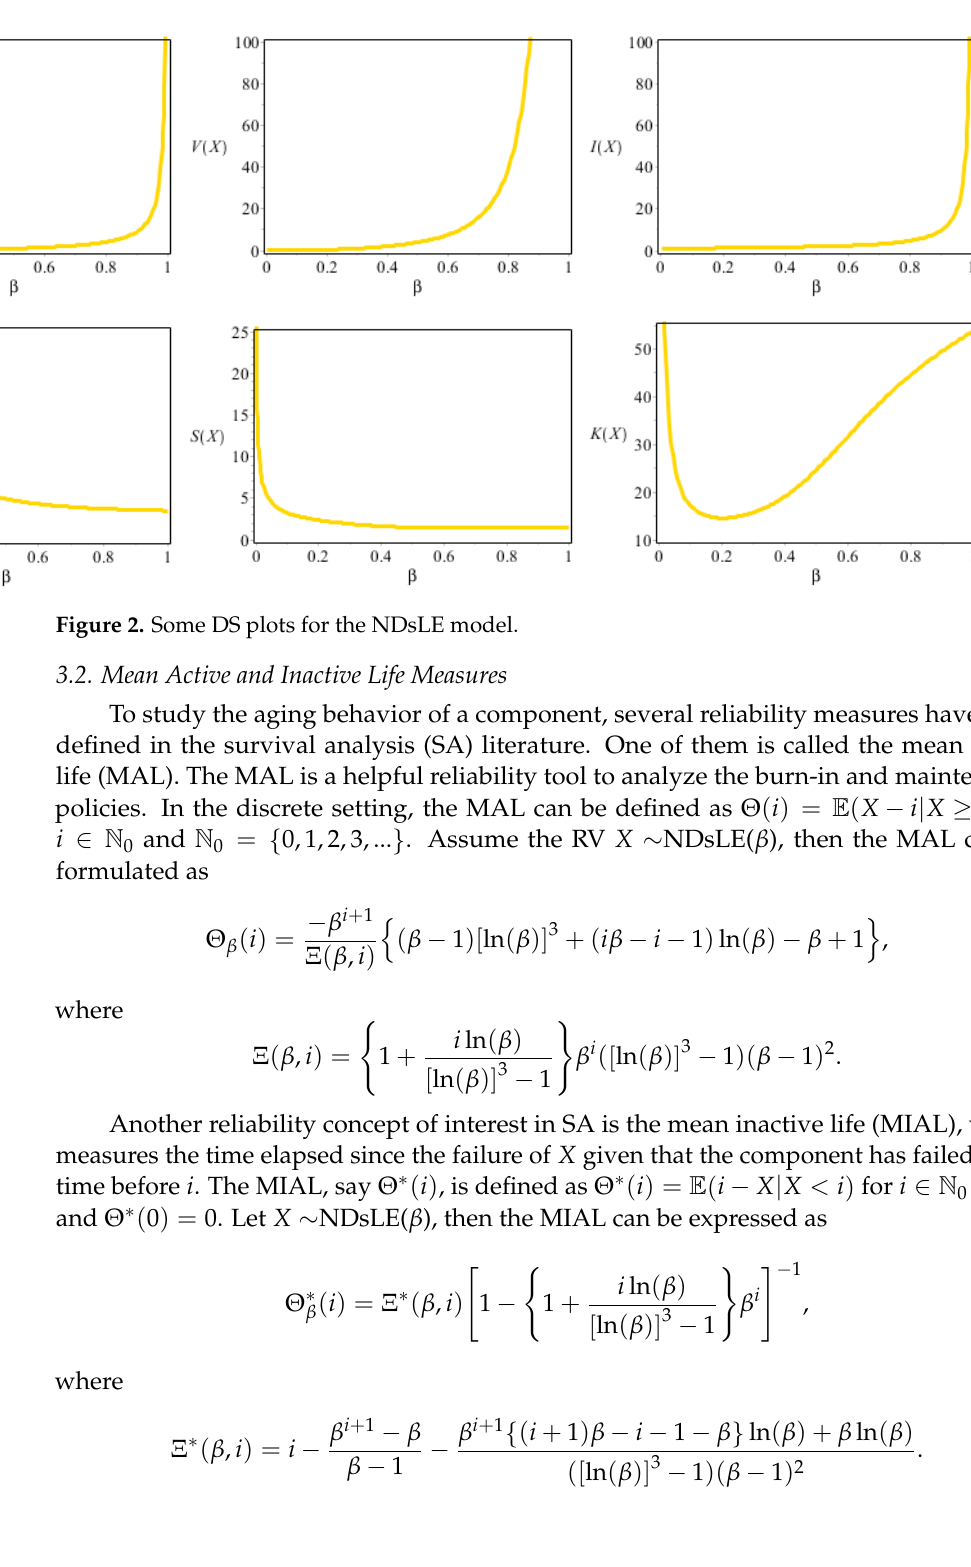
: (9) Table 1 lists some numerical results of some descriptive statistics (DS) for the NDsLE model for di⁄erent values of the parameter (cid:12) . Table 1. Some DS for the NDsLE model under various values of (cid:12) . (cid:12)